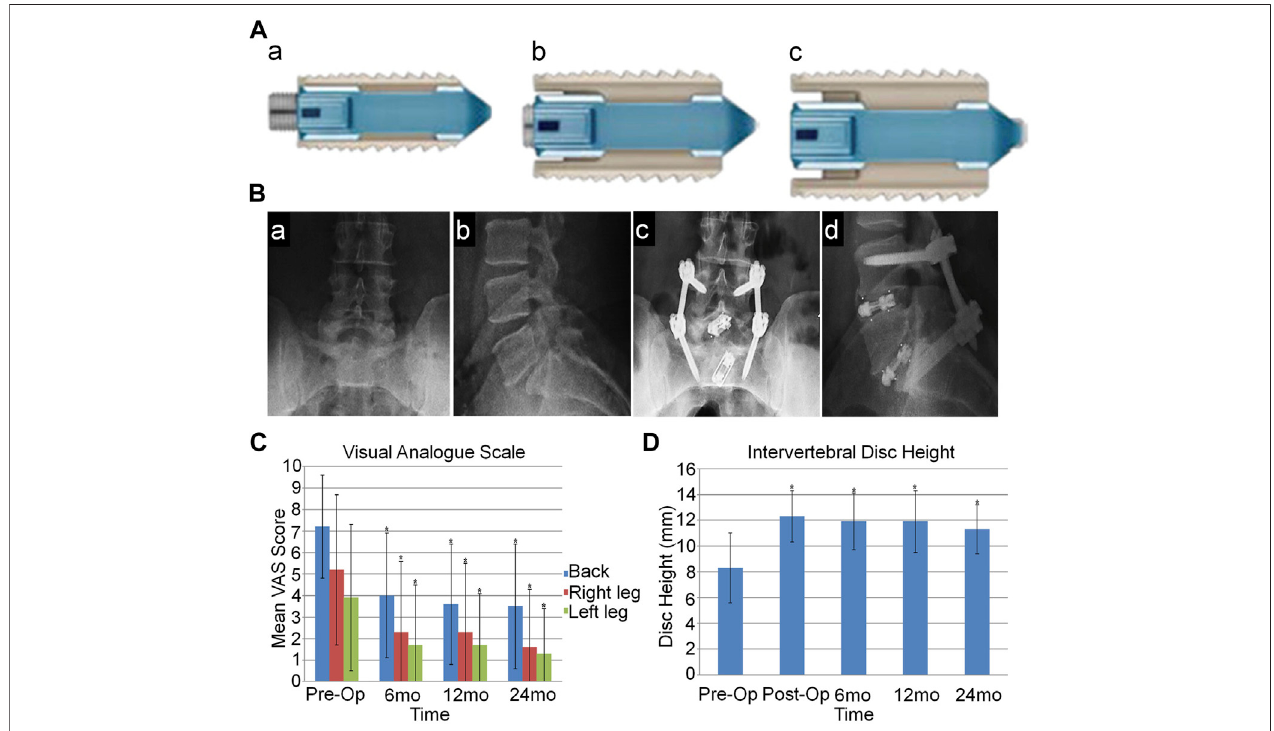
FIGURE 2 | (A) Lateral view of the expandable interbody cage. The implant is shown in contracted (A) , expanding (B) , and fully expanded (C) conditions. (B) Preoperative anteroposterior (A) and lateral (B) plain- fi lm radiographic images of the lumbosacral spine. Postoperative anteroposterior (C) and lateral (D) radiographic images of the lumbosacral spine demonstrating 2-level interbody reconstruction and transpedicular screw and rod instrumentation at L4eS1. (C) The bar graph shows visual analog scale scores for patients from the preoperative assessment through 24 months of follow-up. (D) The graph shows intervertebral disc heights of patients from the preoperative assessment through 24 months of follow-up (mean ± standard deviation values) (Kim et al.,